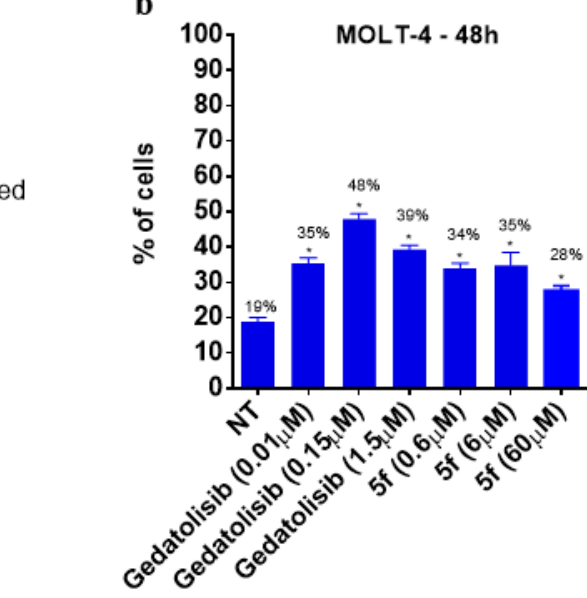
Figure 7. E ff ect of gedatolisib ( 4 ) and LASSBio-2252 ( 5f ) on the PI3K activation and phosphorylation in CCRF-CEM cell line at 48 h. Data are presented as mean ± standard error of mean, * p < 0.05 compared to the untreated group (DMSO 1%); the graphs represent: ( a ) all PI3K tag states, ( b ) PI3K inactivated.